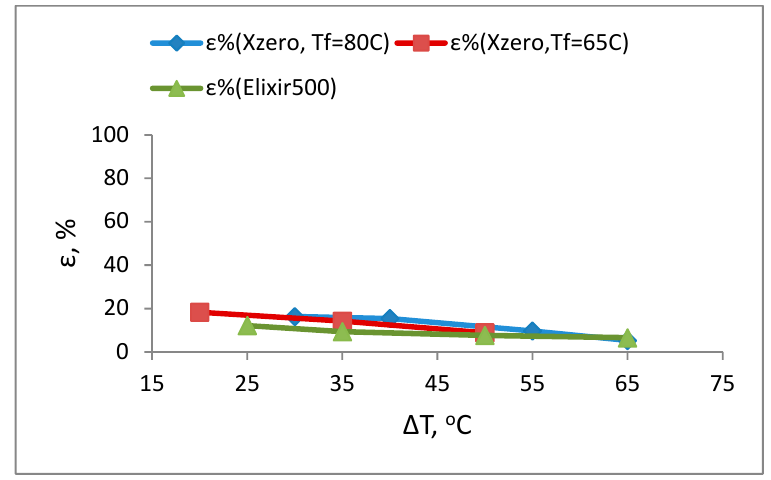
Figure 7. Exergy destructions and specific heat demand at different feed–coolant temperature differences for fixed feed temperatures of 80 °C (for both modules) and 65 °C (only for Xzero).